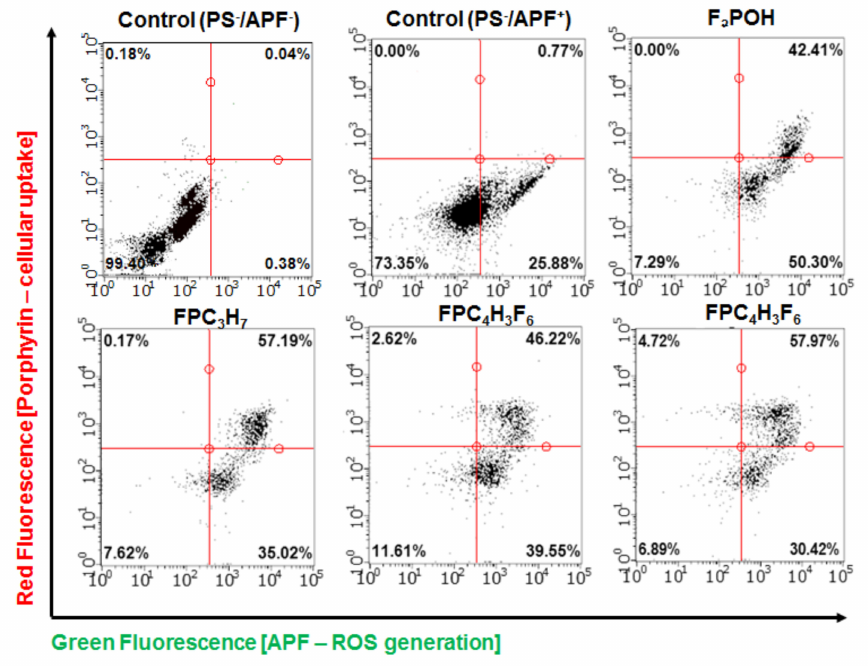
Figure 7. Flow cytometry analysis of reactive oxygen species (ROS) generation in vitro . After incubation of the cells with PS (24 h) and APF (2 h), the cells were irradiated. The level of ROS was monitored by the APF fluorescence signal in the green channel and the cellular uptake (red porphyrin fluorescence) was detected as an increased red fluorescence